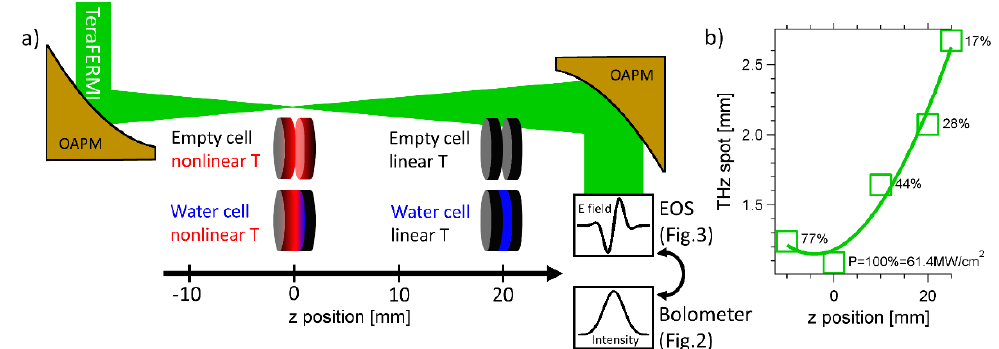
Figure 1. a) Sketch of the experimental setup. The terahertz source is TeraFERMI at the FERMI free-electron laser at the Elettra synchrotron. The beam path of the THz radiation is shown in green and routed with two off-axis parabolic mirror (OAPM). The sample holder is moved through the THz focus with a computer-controlled stage. The nonlinear transmission (red) reaches a maximum at the THz focal position (z=0). When the static cell is empty, the nonlinear response can originate from the diamond windows (black). When the liquid holder is filled with water (blue), the nonlinear response can also originate from the liquid layer. Away from the focus, the transmission approaches the linear value (z>20 mm). Two detecting apparatuses are alternatively used to measure the field (electro-optical sampling, EOS) or its intensity (silicon bolometer). b) THz beam properties measured with a camera placed at the sample position. The green squares indicate the full-width at half maximum (FWHM) of the THz spot size measured as a function of the position of the z stage. The solid green line is a guide to the eye. The THz spot is ca. 1.1 mm at the focus z=0. In this position, the peak power is maximum and amounts to P=100%=61.4 MW/cm 2 . Moving away from the focus, P decreases for increasing THz spot area.